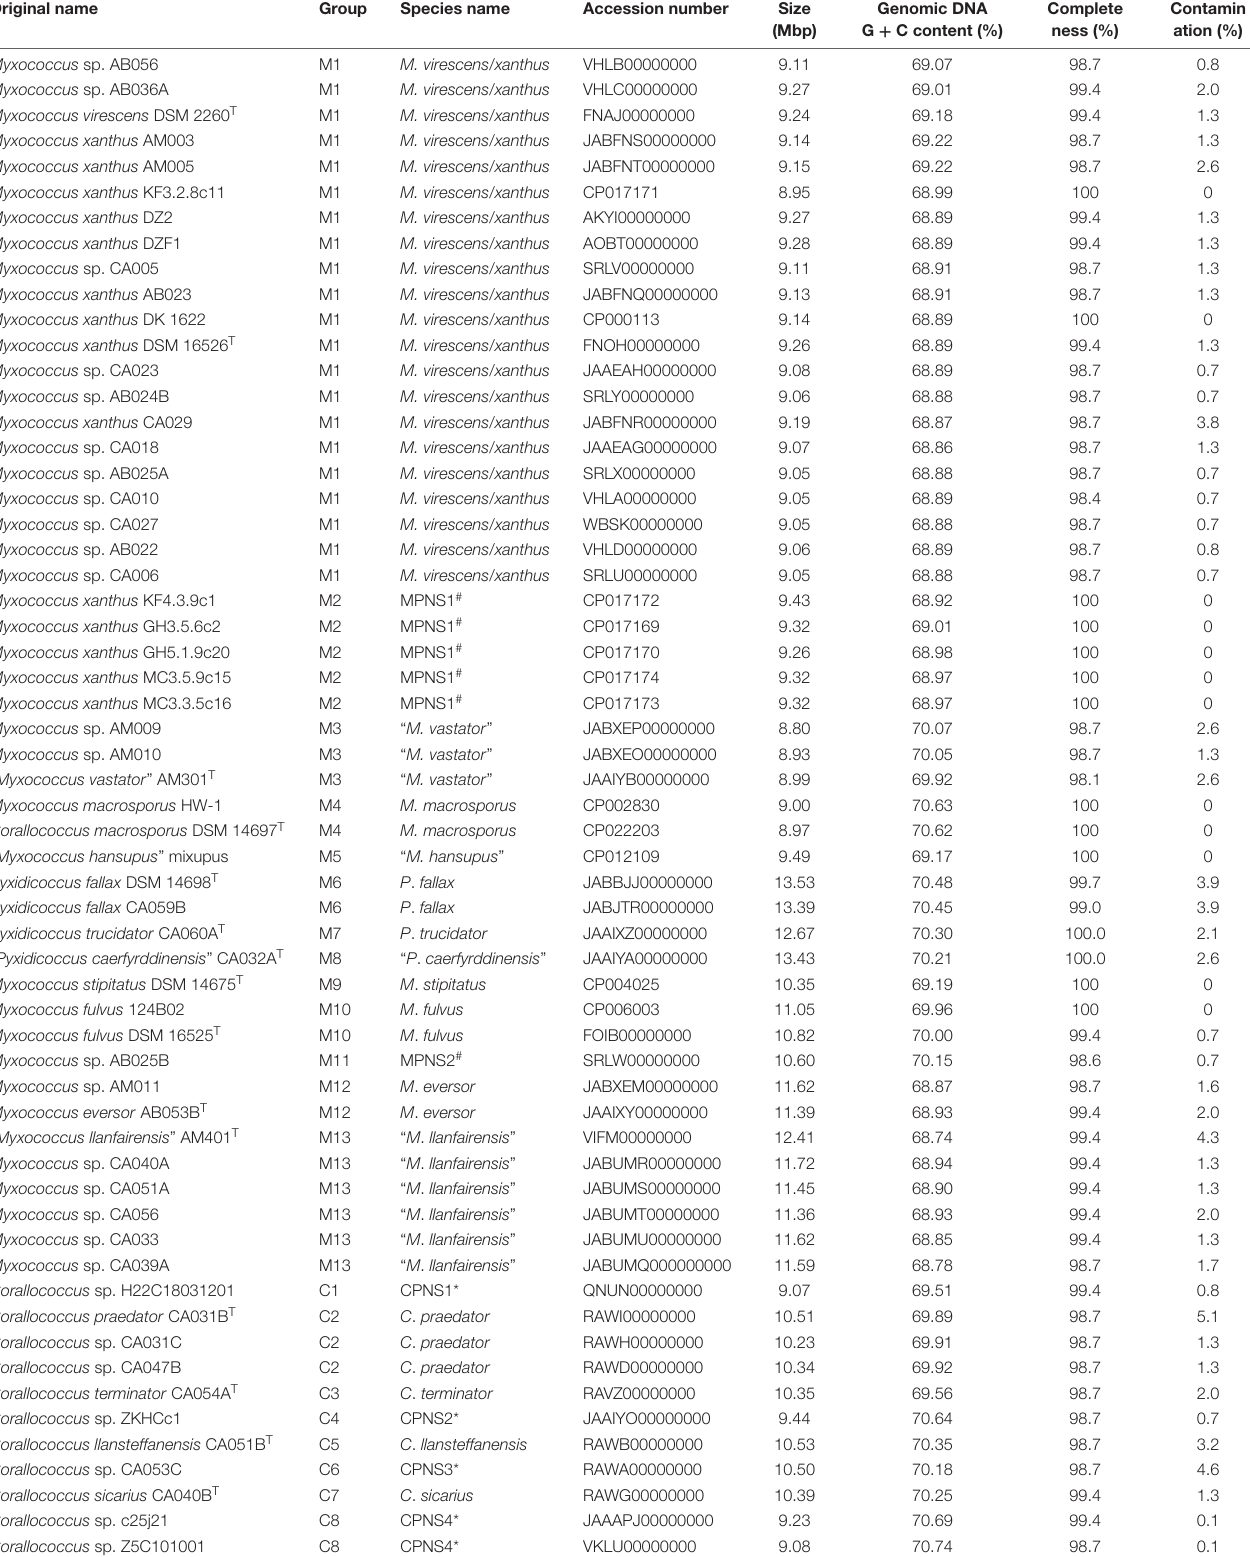
TABLE 1 | The detailed information on genomes used in this